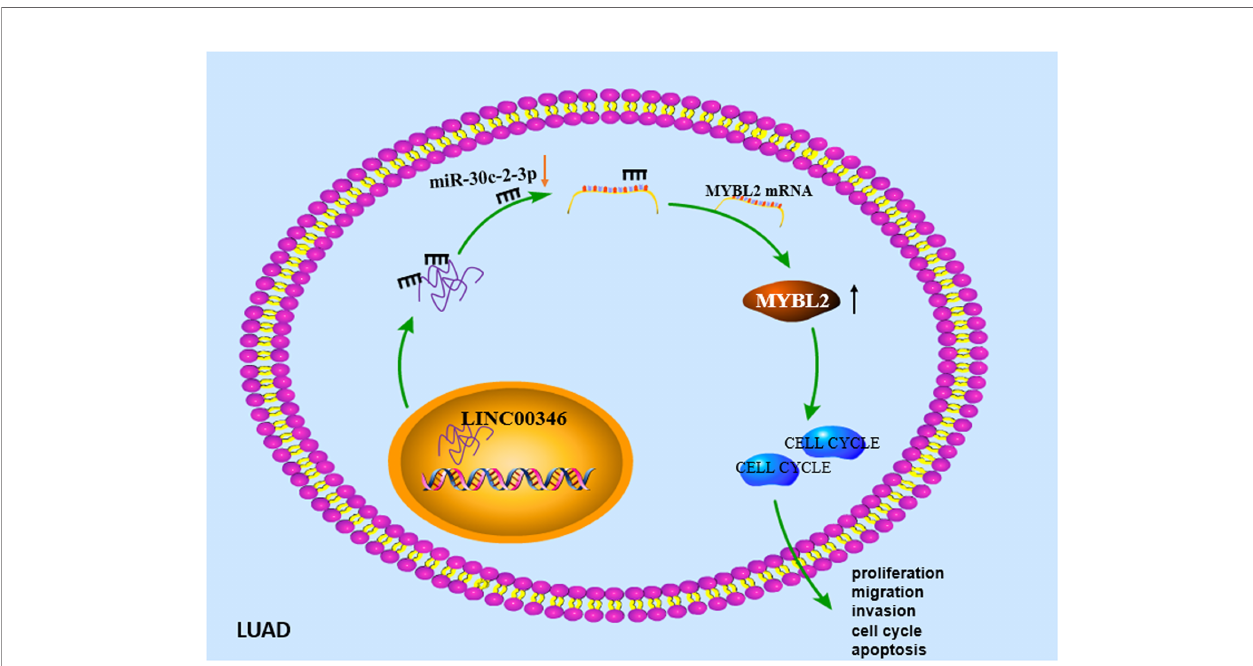
FIGURE 8 | Molecular mechanism diagram of LINC00346/miR-30c-2-3p/MYBL2 axis regulating cell cycle signaling pathway to promote malignant progression of